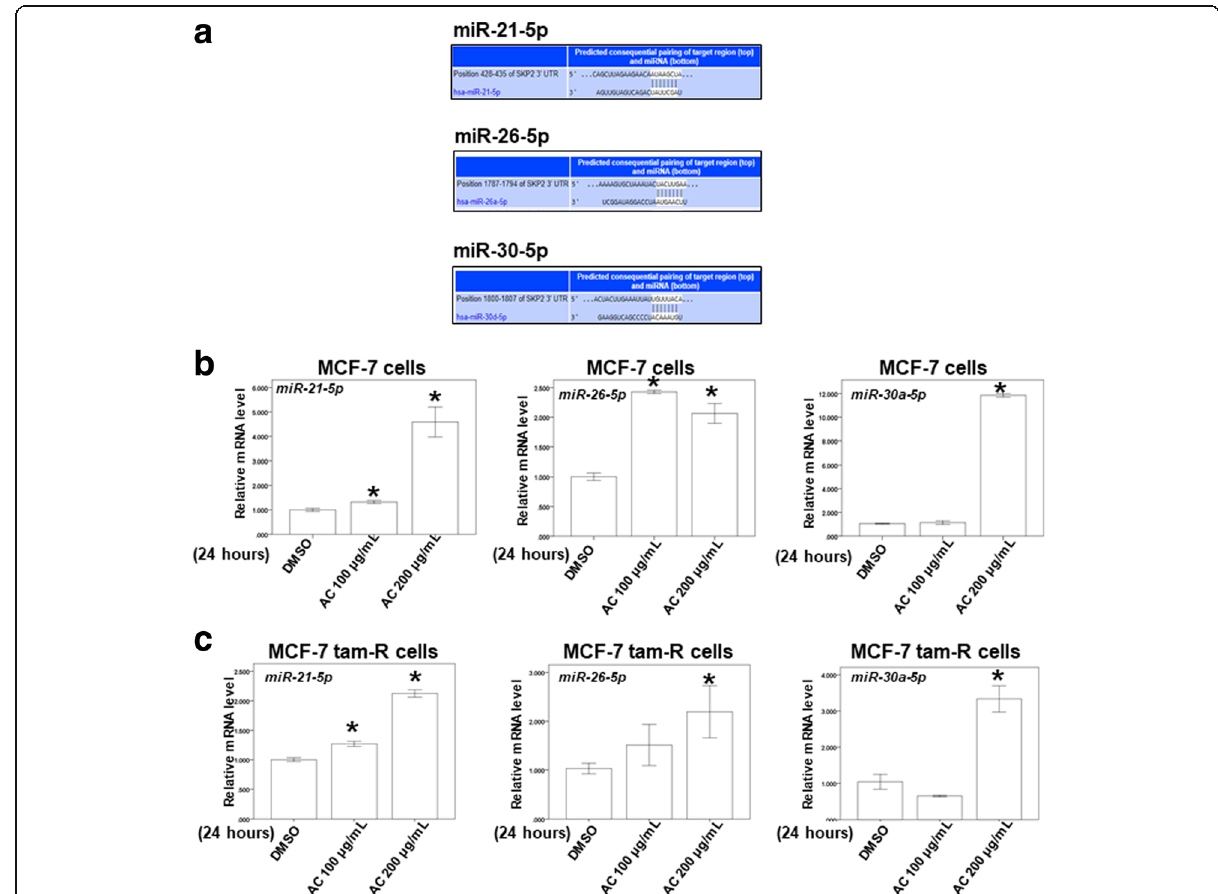
Fig. 5 The effect of AC on the microRNA expression of miR-21-5p, miR-26-5p and miR-30a-5p. a miRNA target prediction of skp2. The conserved miR-21-5p, miR-26-5p and miR-30a-5p binding sites in skp2 3 ’ -UTR region are detected by TargetScan analysis. b-c Total microRNA was extracted from the two breast cancer cells after treat without or with indicated drugs for 24 h. The coding regions of miR-21-5p, miR-26-5p and miR-30a-5p were used as probes for real time polymerase chain reaction analysis. (Error bars = mean ± S.E.M. Asterisks (*) mark samples significantly different from DMSO group with p <